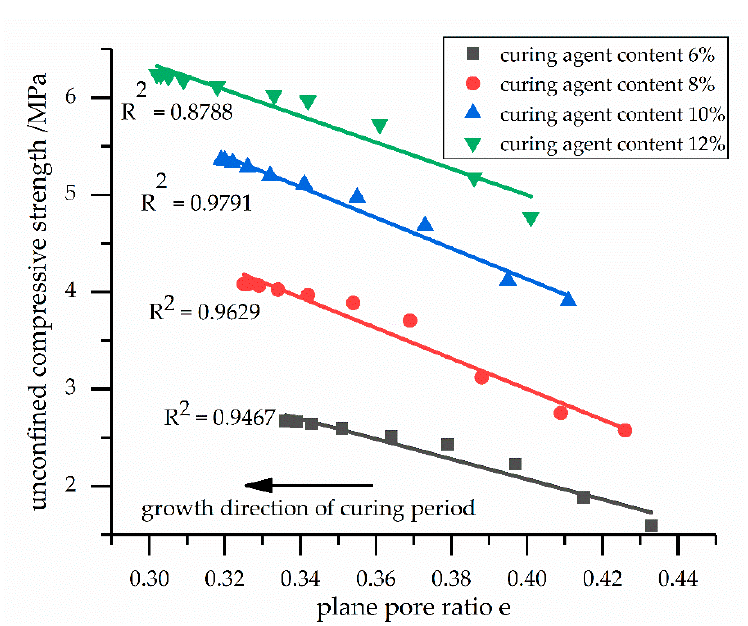
Figure 8. Dependence between the unconfined compressive strength and the plane pore ratio.